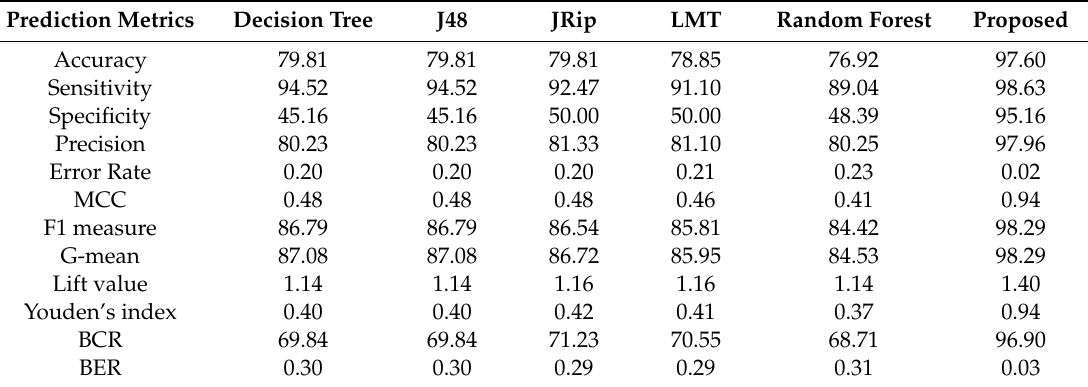
Table 9. GLCM_135 dataset.